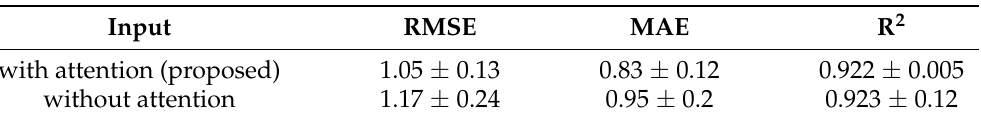
Table 2. Mean and standard deviation of RMSE, MAE, and R 2 values obtained using the proposed models with and without the attention mechanism in the EE